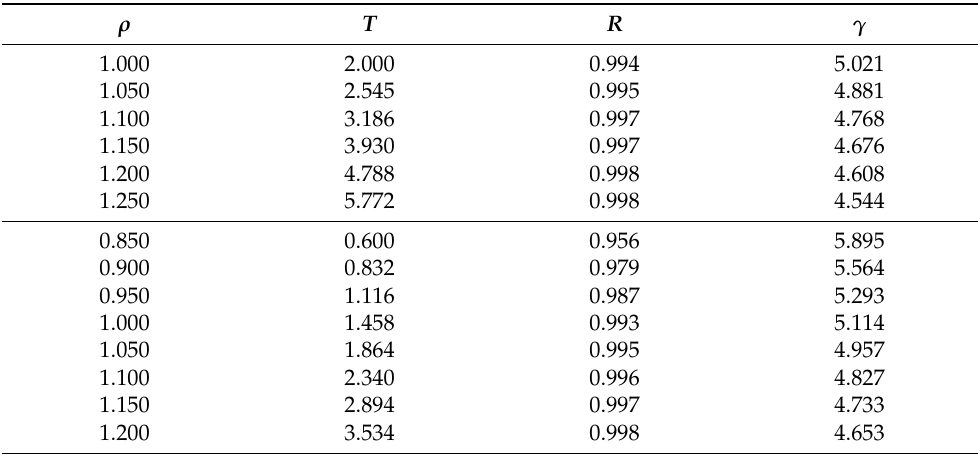
Table A1. Selected LJ state points of isomorph 1 (top) and isomorph 2 (bottom) (Figures 1 and 2).